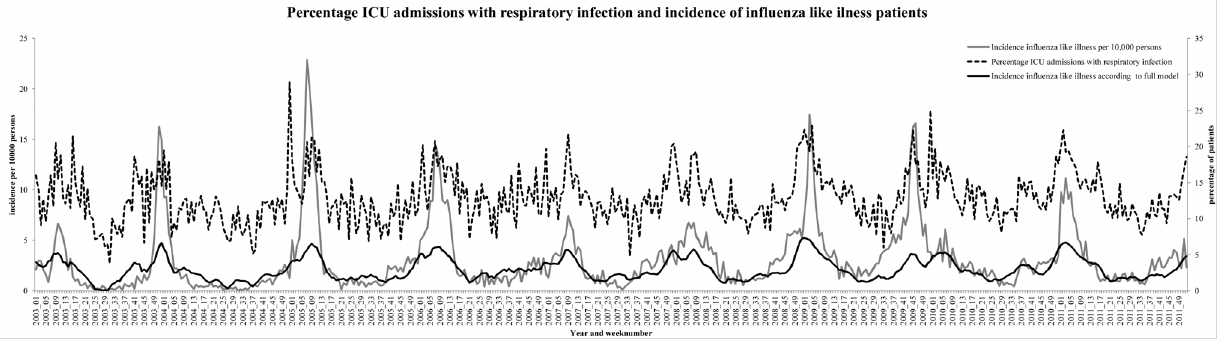
Figure 1. Percentage of medical Intensive Care Unit (ICU) admission with respiratory infection, and incidence of Influenza Like Illness (ILI) cases in the period 2003–2011. Incidence of ILI is plotted per 10,000 population per week. The ILI according to the full model is also plotted. doi:10.1371/journal.pone.0083854.g001 PLOS ONE |